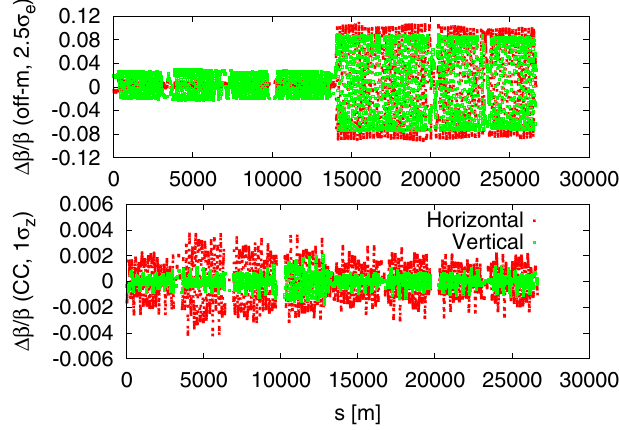
FIG. 11. (Color) Off-momentum beta beating for the nominal LHC optics with a relative momentum offset of 0.000 27 (top); z -dependent beta beating due to the global crab cavity (bottom), which is much smaller than the off-momentum beta beating.